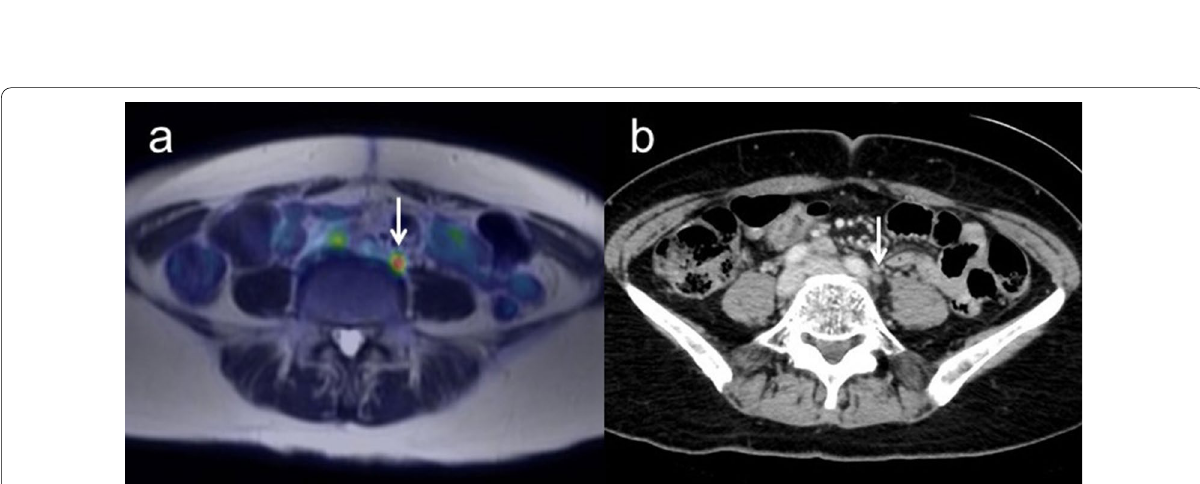
Fig. 6 a A 63-year-old woman with pathologically confirmed ovarian cancer. During follow-up after the successful initial treatment, including surgery and first-line chemotherapy, CA-125 gradually increased. Axial T2-weighted PET/MR image shows the left para-aortic lymph node with FDG uptake (arrow). b Contrast-enhanced CT shows the left para-aortic lymph node less than 1 cm in short-axis diameter with slightly enhancement (arrow). After second-line chemotherapy, this lymph node decreased in size and SUV, suggesting this node as a sign of